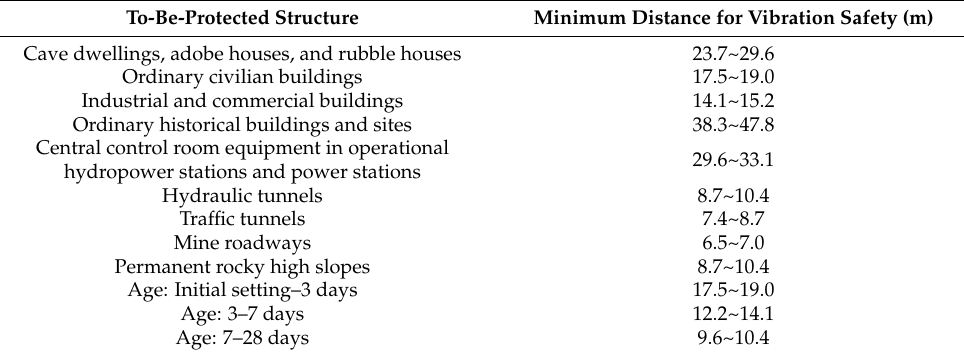
Table 7. Minimum distance for the vibration safety of a 1 t TNT blast. To-Be-Protected Structure